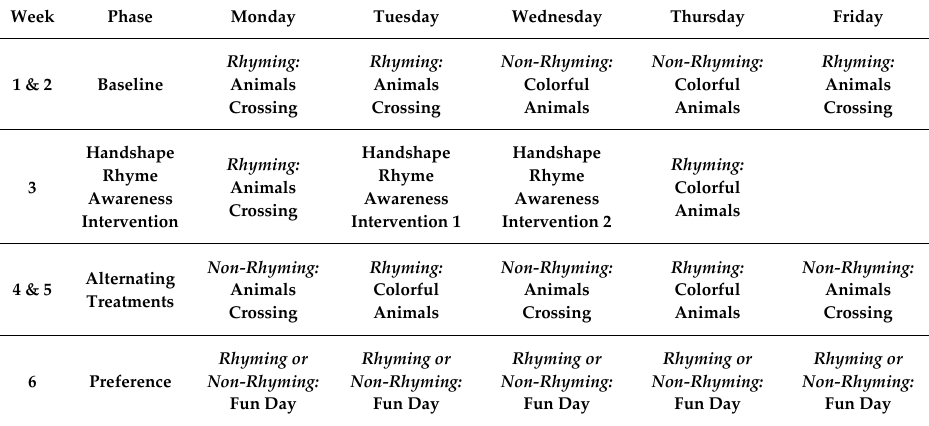
Figure 1. Intervention Schedule.